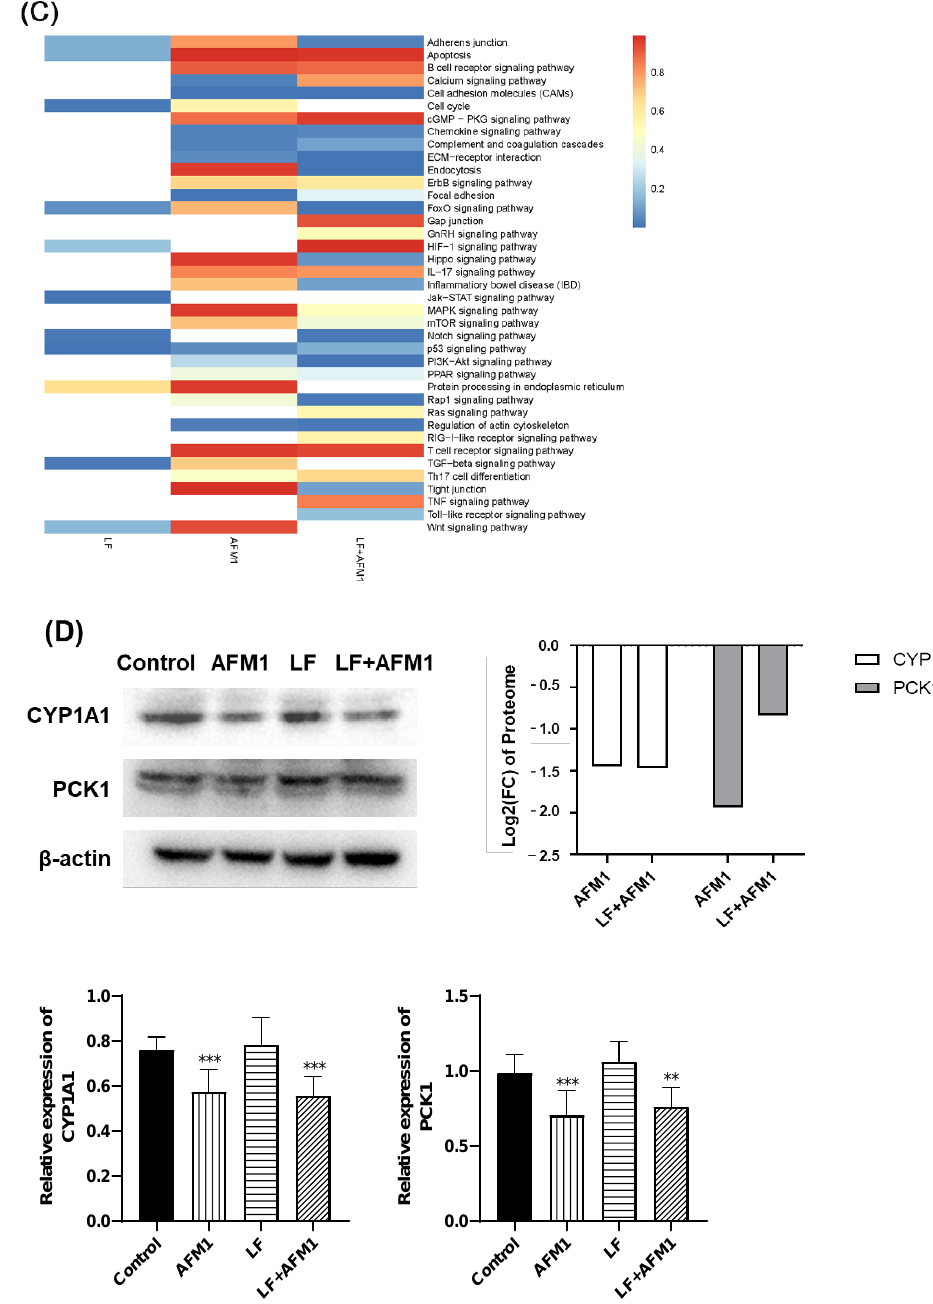
Figure 6. Proteome analysis of differentiated Caco-2 cells exposed to LF and AFM1. ( A ) The number of differentially expressed proteins (DEPs). ( B ) Venn diagram depicting the DEGs regulated by LF and AFM1 treatment. ( C ) The intestinal integrity-related KEGG pathways enriched by DEPs. ( D ) The protein expression level measured by Western blotting and expressed as the mean ± SEM of three independent experiments. LF represents individual treatment with 100 μg/mL LF, AFM1 represents individual treatment with 8 μg/mL AFM1, and LM represents combined treatment with of 100 μg/mL LF and 8 μg/mL AFM1. ** represents p < 0.01, *** represents p < 0.001.